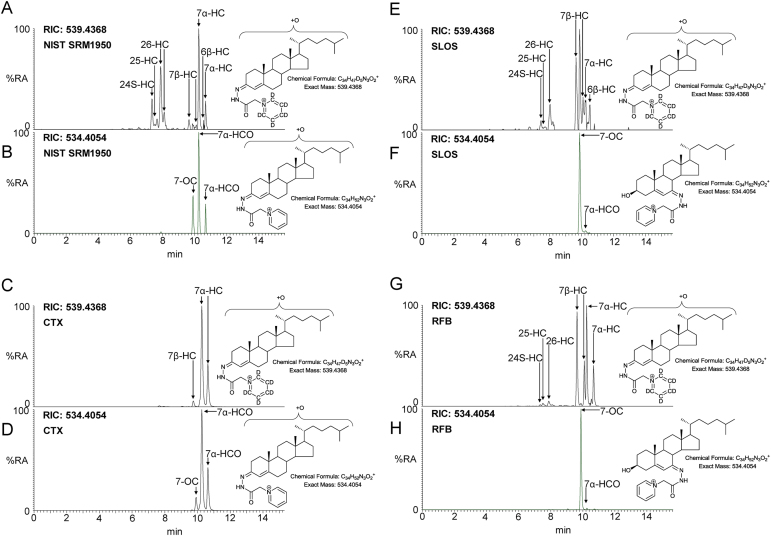
Reconstructed-ion chromatograms (RICs) displaying how 7α-HC, 7β-HC, 7α-HCO and 7-OC vary in plasma in health and disease and according to sample storage. (A) RIC from NIST SRM1950 plasma treated with cholesterol oxidase and (B) in the absence of cholesterol oxidase. (C) RIC from a typical CTX plasma sample treated with cholesterol oxidase and (D) in the absence of cholesterol oxidase. (E) RIC from a typical SLOS plasma sample treated with cholesterol oxidase and (F) in the absence of cholesterol oxidase. (G) RIC from a dried plasma sample, transported to Swansea from Germany without precaution being taken against oxidation in air, treated with cholesterol oxidase and (H) in the absence of cholesterol oxidase. Aliquots of sample prepared in the presence of cholesterol oxidase were derivatised with [2H5]GP and those prepared in the absence of cholesterol oxidase with [2H0]GP. Analyte concentrations are given in supplementary Table S1 (Crick et al., 2015b, Griffiths et al., 2016, Griffiths et al., 2013a, Theofilopoulos et al., 2014).